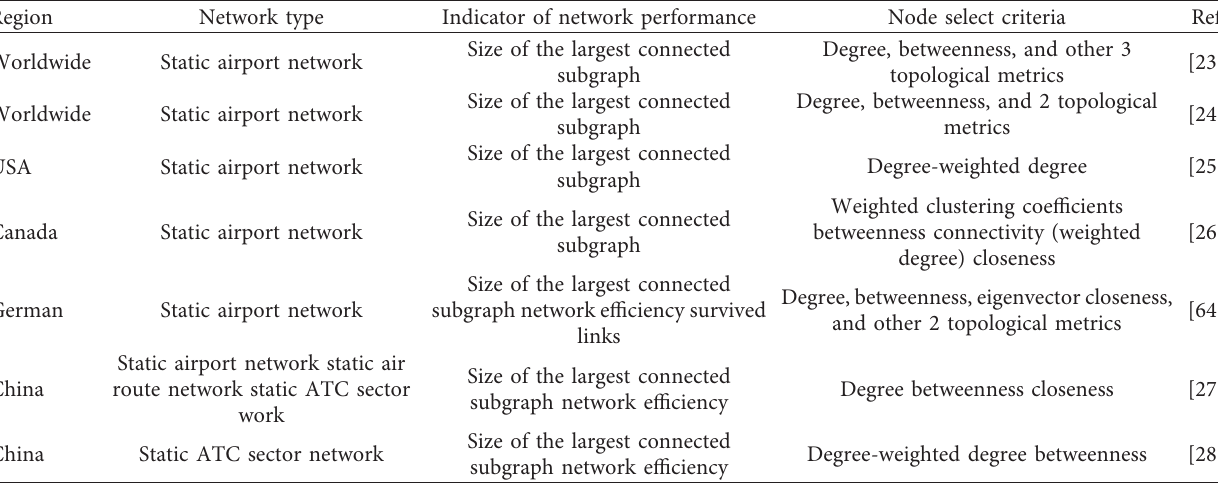
Table 5: Recent impact literatures about robustness in air transport network.